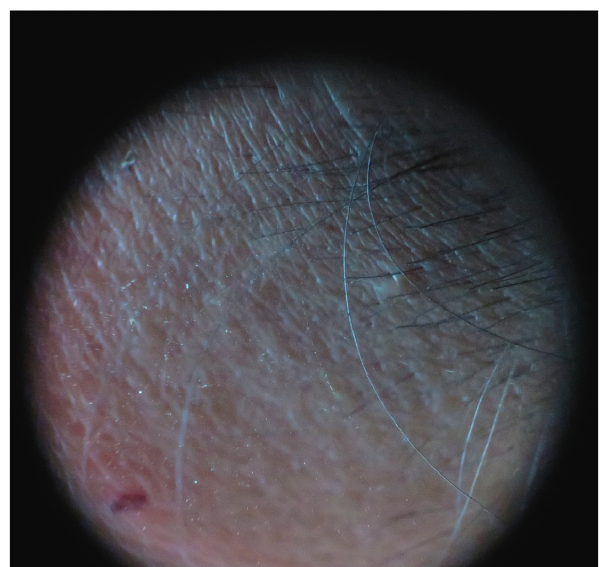
Figure 2: Dermoscopic appearance of